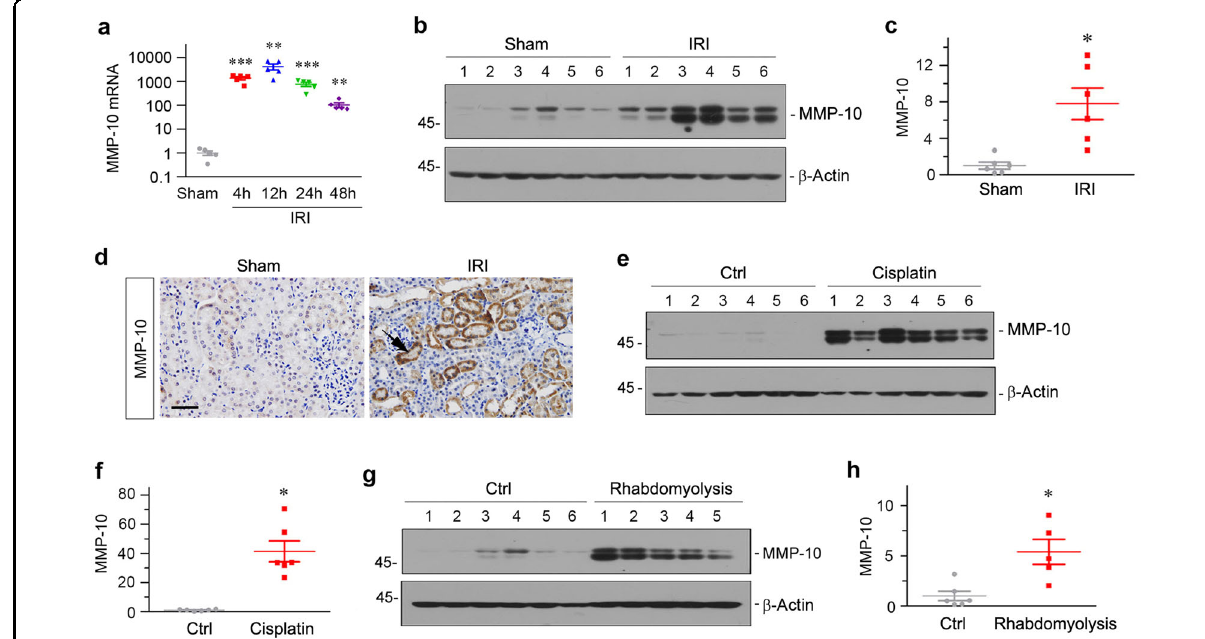
Fig. 1 Matrix metalloproteinase-10 (MMP-10) is induced in various models of AKI. a Quantitative, real-time PCR (qPCR) results show induction of renal MMP-10 mRNA at different time points after IRI as indicated. Relative abundances of renal MMP-10 mRNA were assessed by qPCR, and fold induction over the sham controls was reported. ** P < 0.01, *** P < 0.001 versus sham controls ( n = 5). b , c Western blot analyses show renal expression of MMP-10 protein at 24 hours after IRI. Western blot ( b ) and quantitative data ( c ) are presented. Numbers (1 – 6) indicate each individual animal in a given group. * P < 0.05 vs sham controls. d Representative micrographs show MMP-10 protein localization in sham and ischemic kidneys at 24 h after IRI. Kidney sections were immunohistochemically stained with speci fi c antibody against MMP-10 ( n = 6). Arrow indicates positive staining. Scale bar, 50 µm. e , f Western blot ( e ) and quantitative data ( f ) of r e nal MMP-10 protein in the kidneys after cisplatin injury were presented. Kidney samples were collected at 3 days after cisplatin injection. Numbers (1 – 6) indicate each individual animal in a given group. * P < 0.05 versus controls. ( g , h ) Western blot ( g ) and quantitative data ( h ) show renal MMP-10 expression at 30 h after injection of glycerol. Numbers (1 – 6) indicate each individual animal in a given group. * P < 0.05 versus